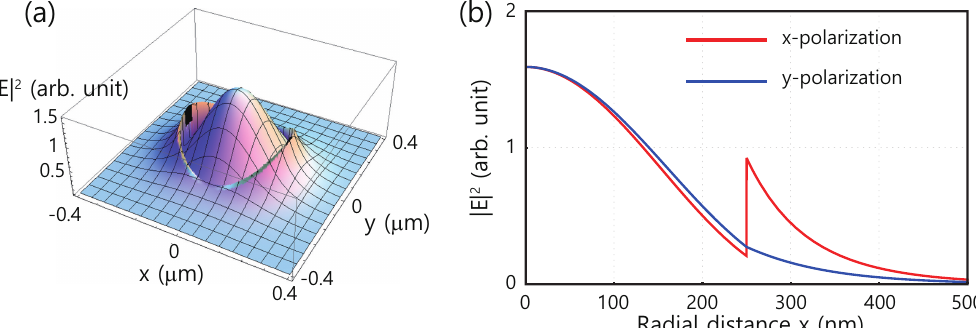
Figure 9. ( a ) The total intensity | E | 2 of the electric field in a fundamental mode HE 11 with quasi-linear polarization. ( b ) Radial dependences of the total intensity | E | 2 of the electric field at φ = 0 ( x -polarization) and φ = π /2 ( y -polarization). Parameters are same as used in Figure 6. Figure 9b shows the spatial distribution of the field along the different polarization